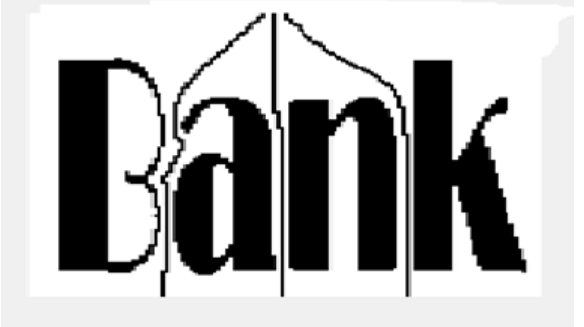
Figure 3. Pre-processed textual images after utilising gradient image and contrast image techniques.